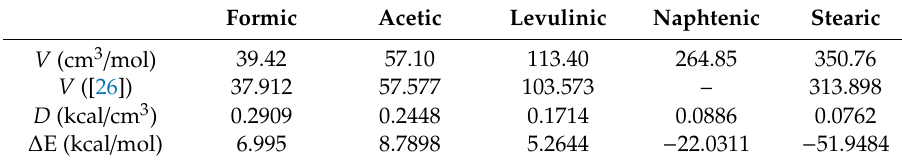
Table 5. Adsorption energy densities of acids and the deformation energy.